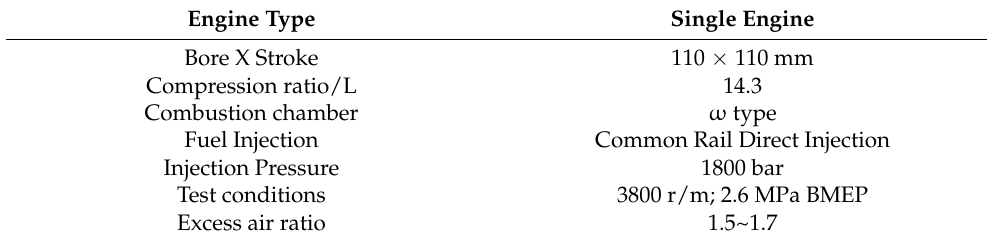
Table 2. Boosted diesel engine test system.